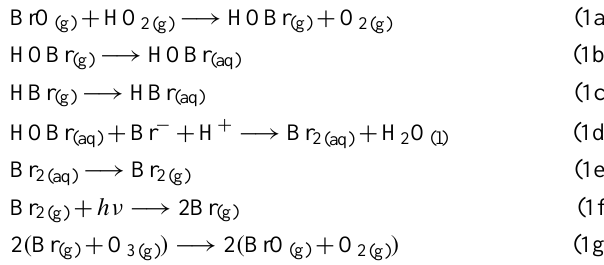
Table 1. Table of reported depletions of O 3 in tropospheric volcanic